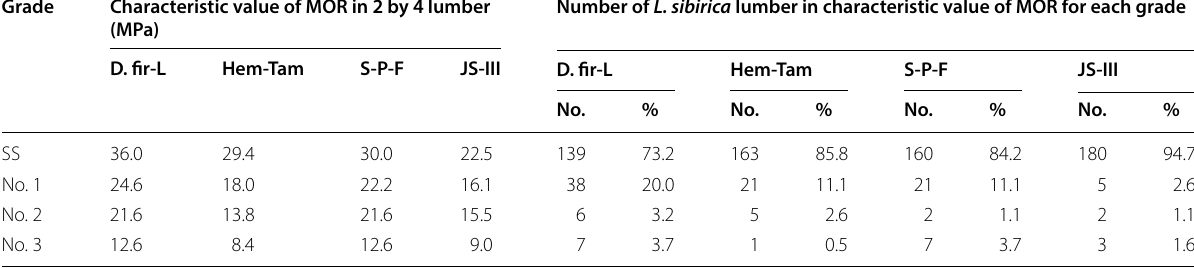
Fig. 2 Distribution of the MOE and MOR of lumber in L. sibirica. SD standard deviation, n number of